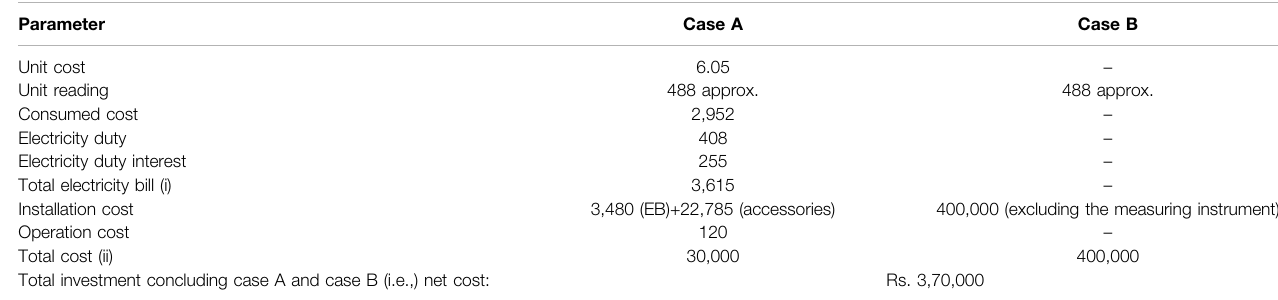
TABLE 2 | Analysis of the developed hybrid power generation